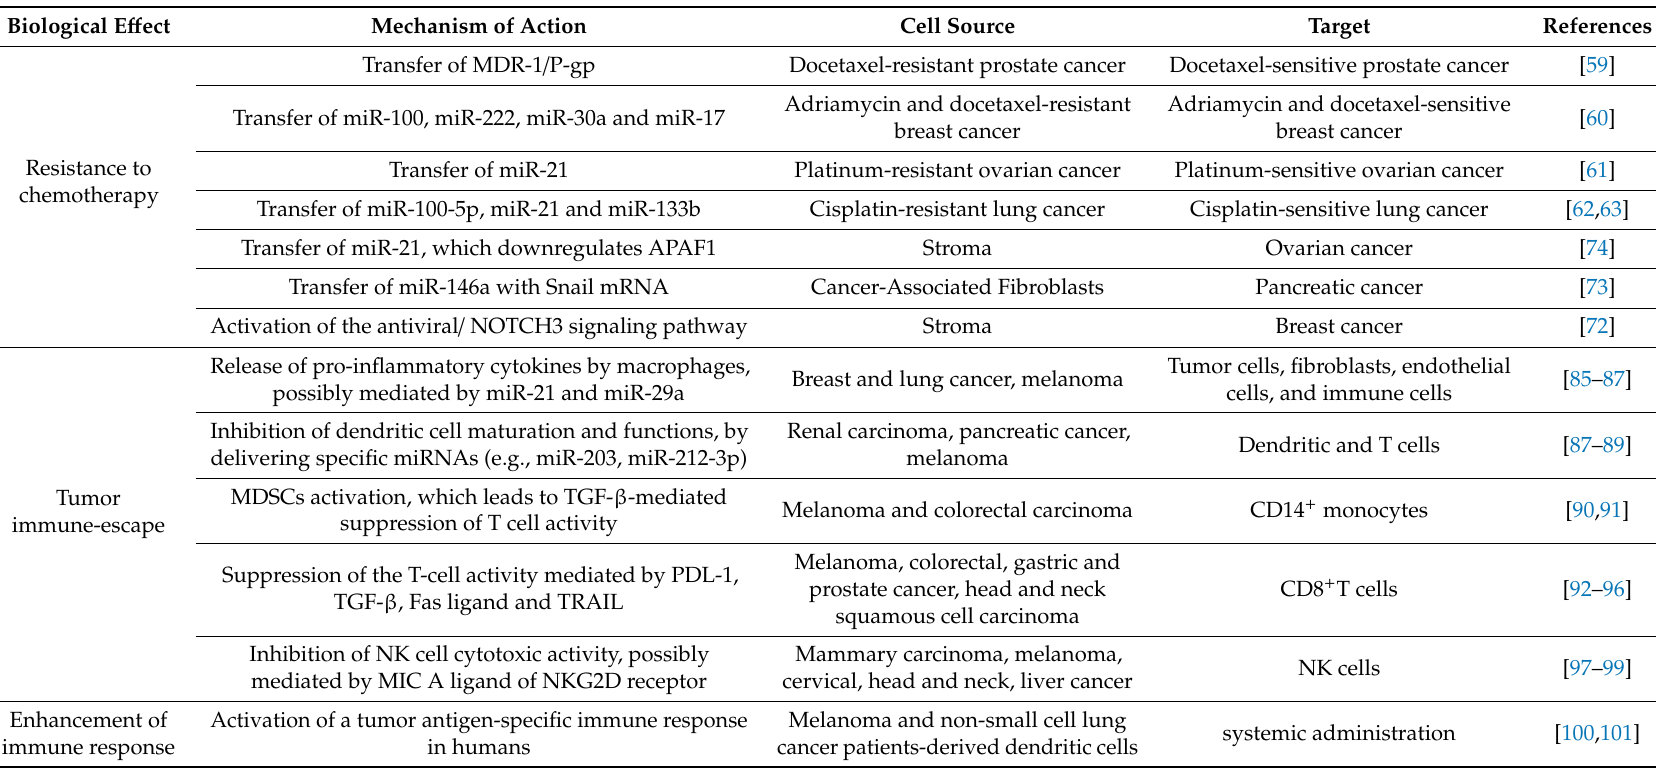
Table 1. The role of EVs in chemo-resistance and immune-modulation. Several proteins and exRNAs have been described to be involved in tumor chemo-resistance and